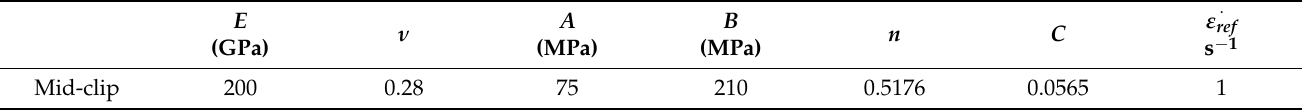
Table 3. Constitutive Johnson–Cook model parameters of the mid-clip [31].